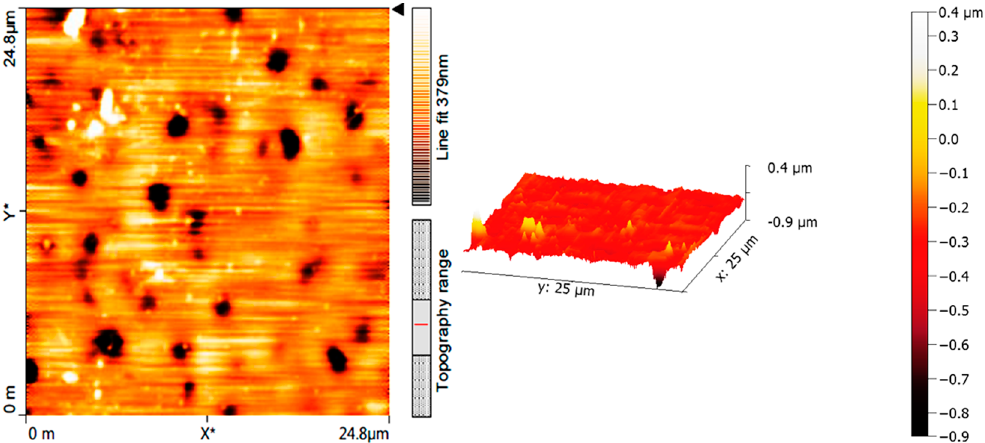
Figure 11. 2D and 3D atomic force microscopy (AFM) images of PVC film (blank) after irradiation (300 h).